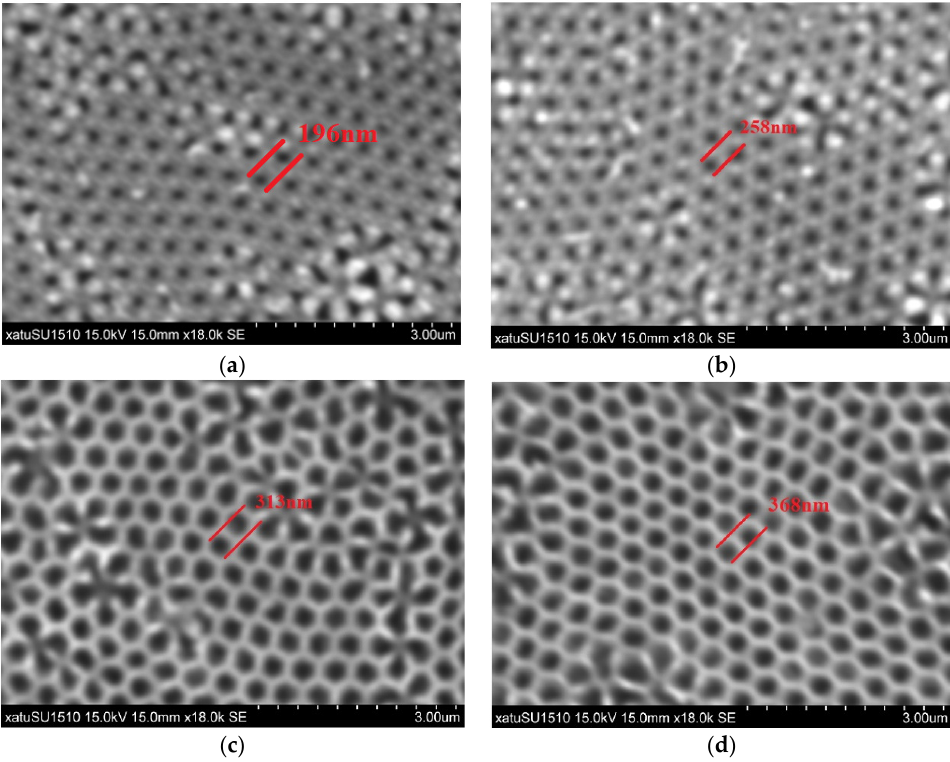
Figure 1. The SEM images of Au films are obtained by replicating the ultra-thin AAO membranes, while the AAO membranes were dissolved with 1.875 mol/L NaOH solution to form a sacrificial layer before SEM images were taken: ( a ) DP450-200S-50000; ( b ) DP450-250S-50000; ( c ) DP450-300S-50000; ( d ) DP450-350S-50000.